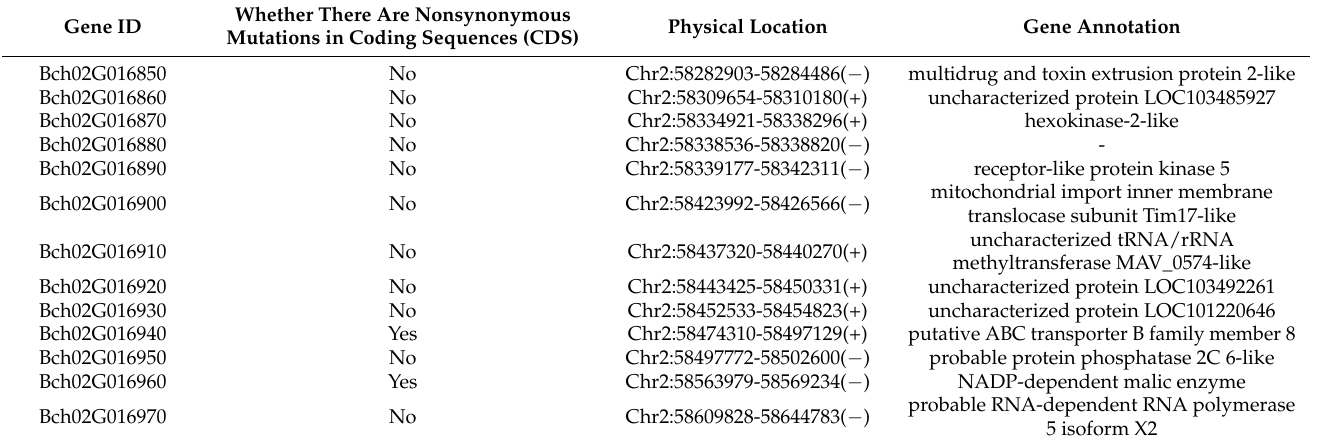
Table 1. List of genes in the QTL